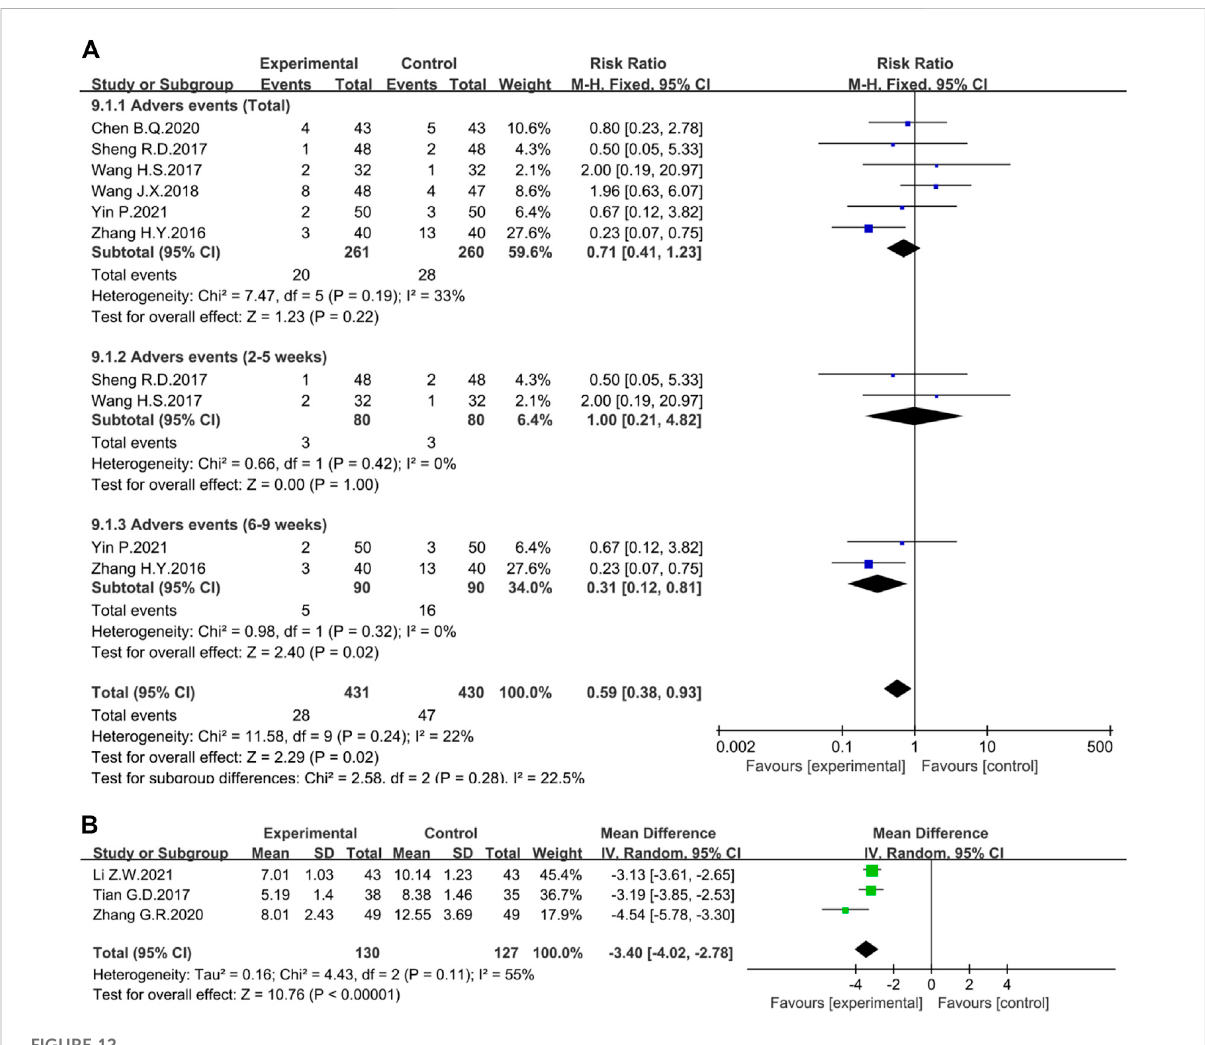
FIGURE 12 Forest plot displaying the results of the Meta-analysis for (A) adverse events and (B) the TCM symptoms